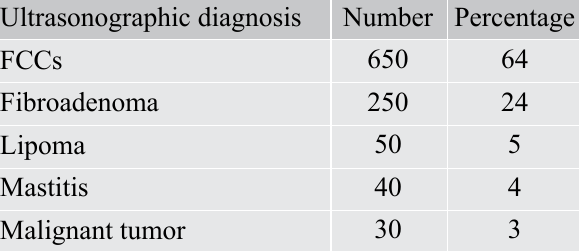
Table III: Distribution of subjects according